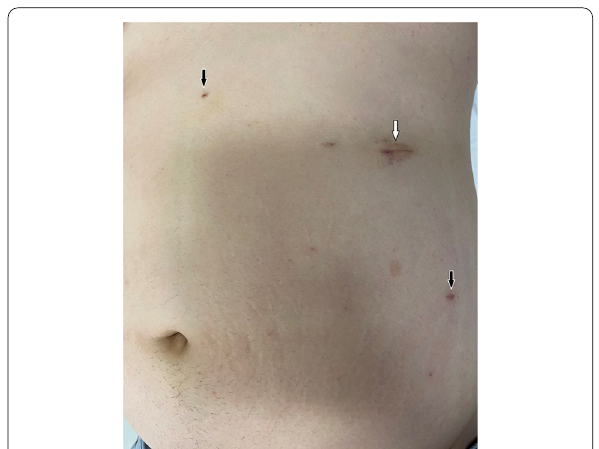
Fig. 5 Skin incision wound postoperatively. The insertion site of 12-mm multichannel trocar (white arrow) and insertion sites of 3-mm trocars (black arrows) are